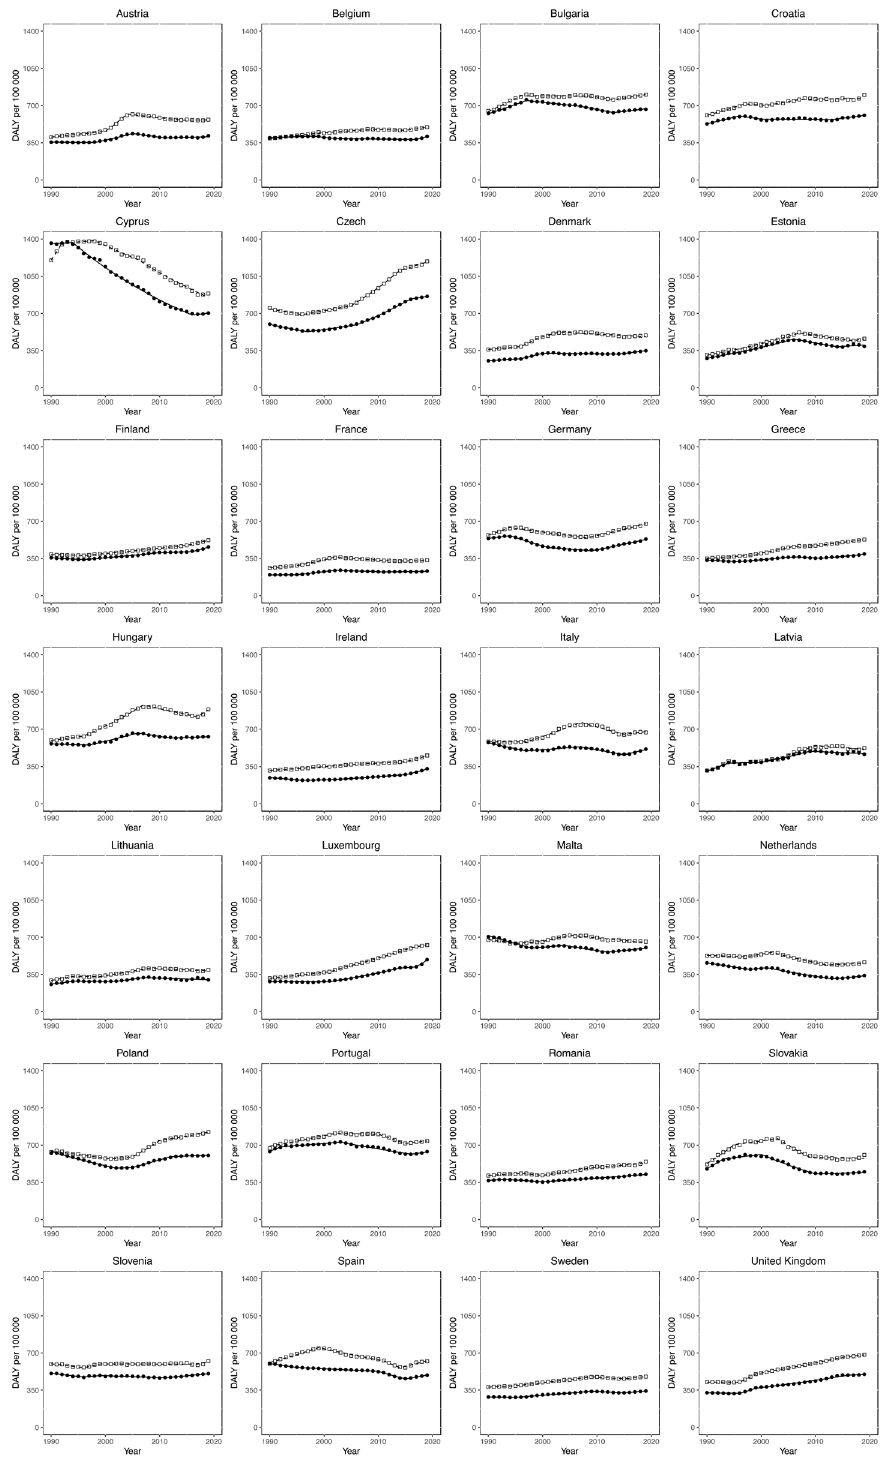
Figure 4. Trends in T2DM DALYs. Trends in age-standardised disability adjusted life years (DALYs) per 100,000 population for type 2 diabetes mellitus (T2DM) in all European Union (EU) countries and the UK from 1990 to 2019. Open squares represent males, filled circles represent